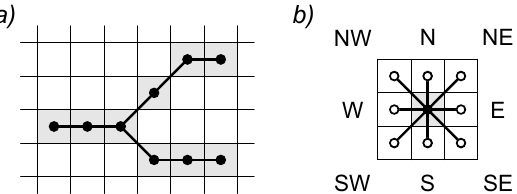
Figure 6. EG generation from skeletonized bitmap. Primal EG vertices (black dots) are uniquely correlated with skeleton pixels (depicted in gray) and are thus constrained to image pixel grids ( a ); edges in primal EG connect only vertices related to adjacent pixels (empty dots), here identified with compass points ( b ).